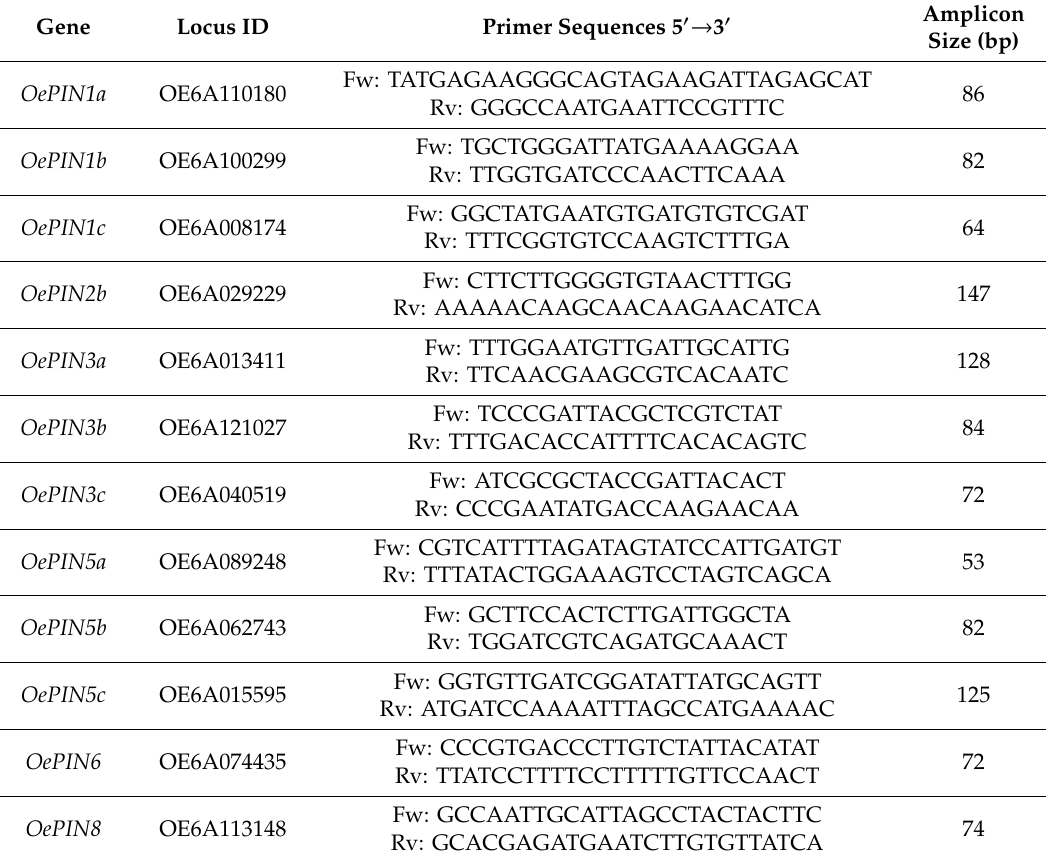
Table 1. Primers used for RT-qPCR analysis designed based on PIN sequences retrieved from Olea euroapaea subsp. europaea var. europaea (cv.